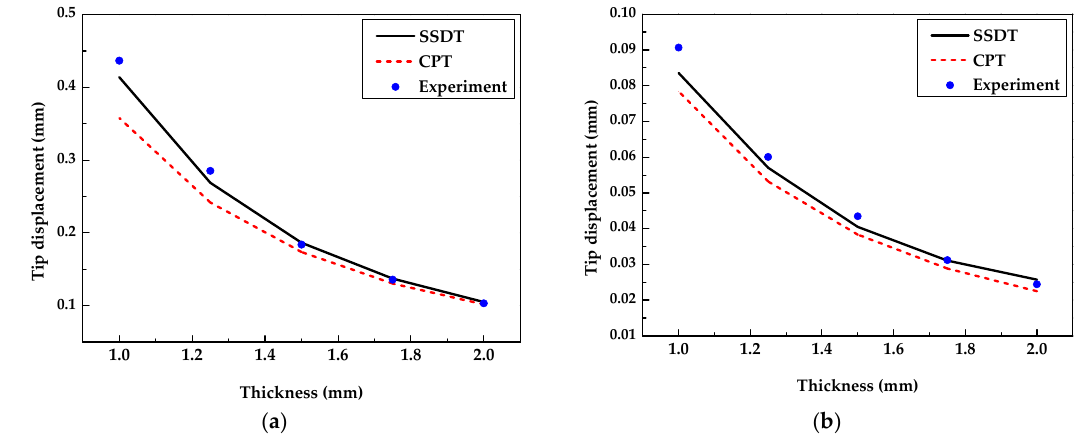
Figure 10. End displacement difference comparison of MFC laminated beams of different thicknesses. ( a ) The P1 type of MFC; ( b ) the P2 type of MFC.